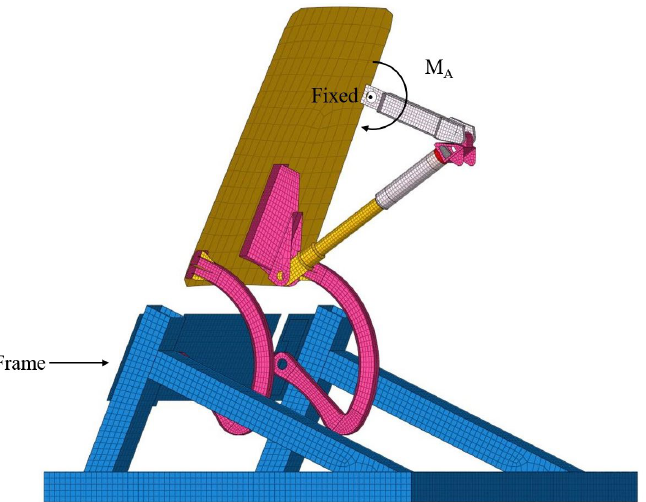
Figure 5. Parametric analysis of the effect of the C t on Dt and F A under different external loading conditions: ( a ) Dt ; ( b ) F A .